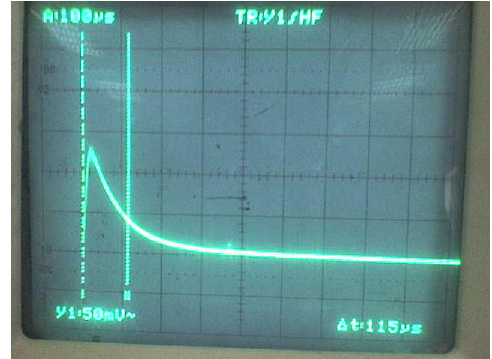
Fig. 5: Open voltage decay